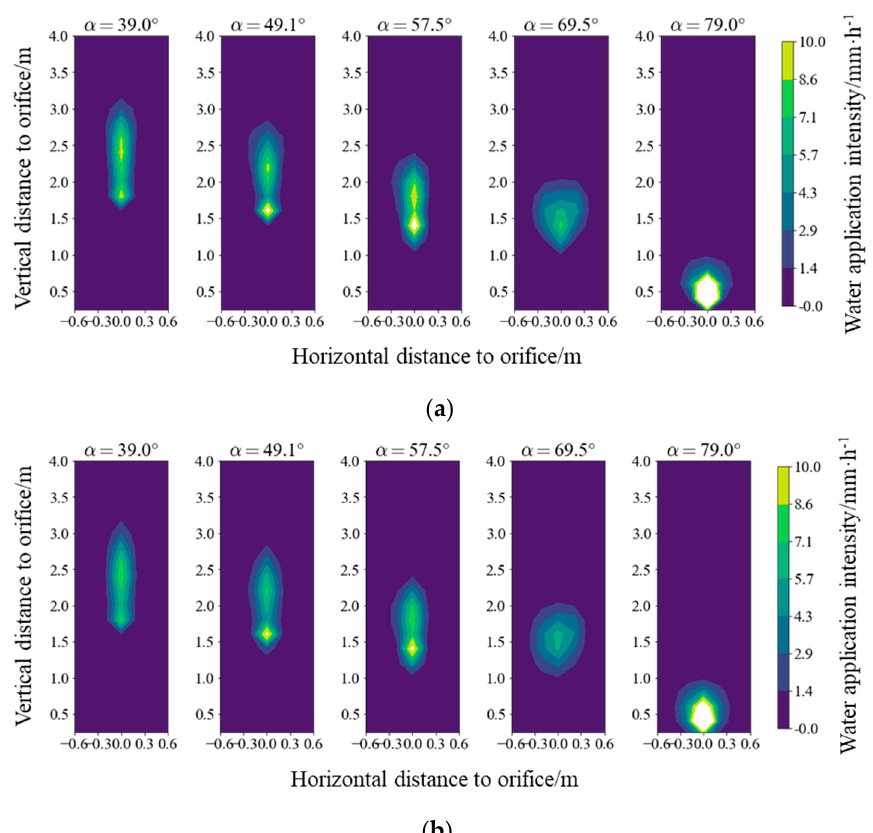
Figure 7. The water application intensity distribution of an individual orifice a 3-6 under different spraying angles at 103 kPa: ( a ) the measured value; and ( b ) the fitting value.